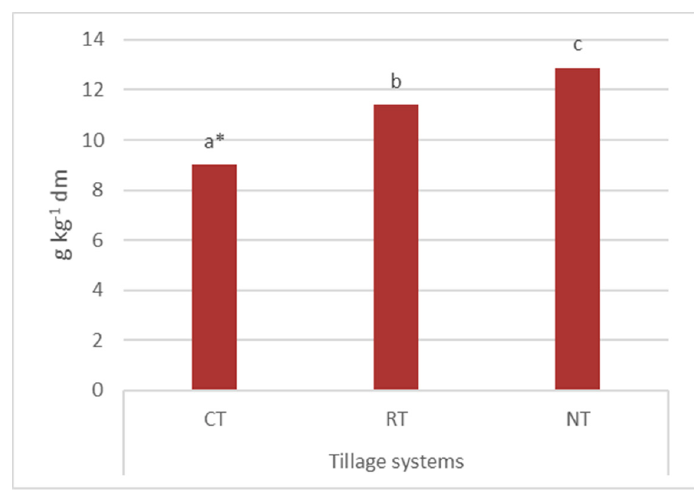
Figure 4. Content of organic C in the 0–25 cm soil layer depending on the tillage system (average of 2014–2016). * a—Means denoted with the same letters do not differ significantly, p < 0.05.